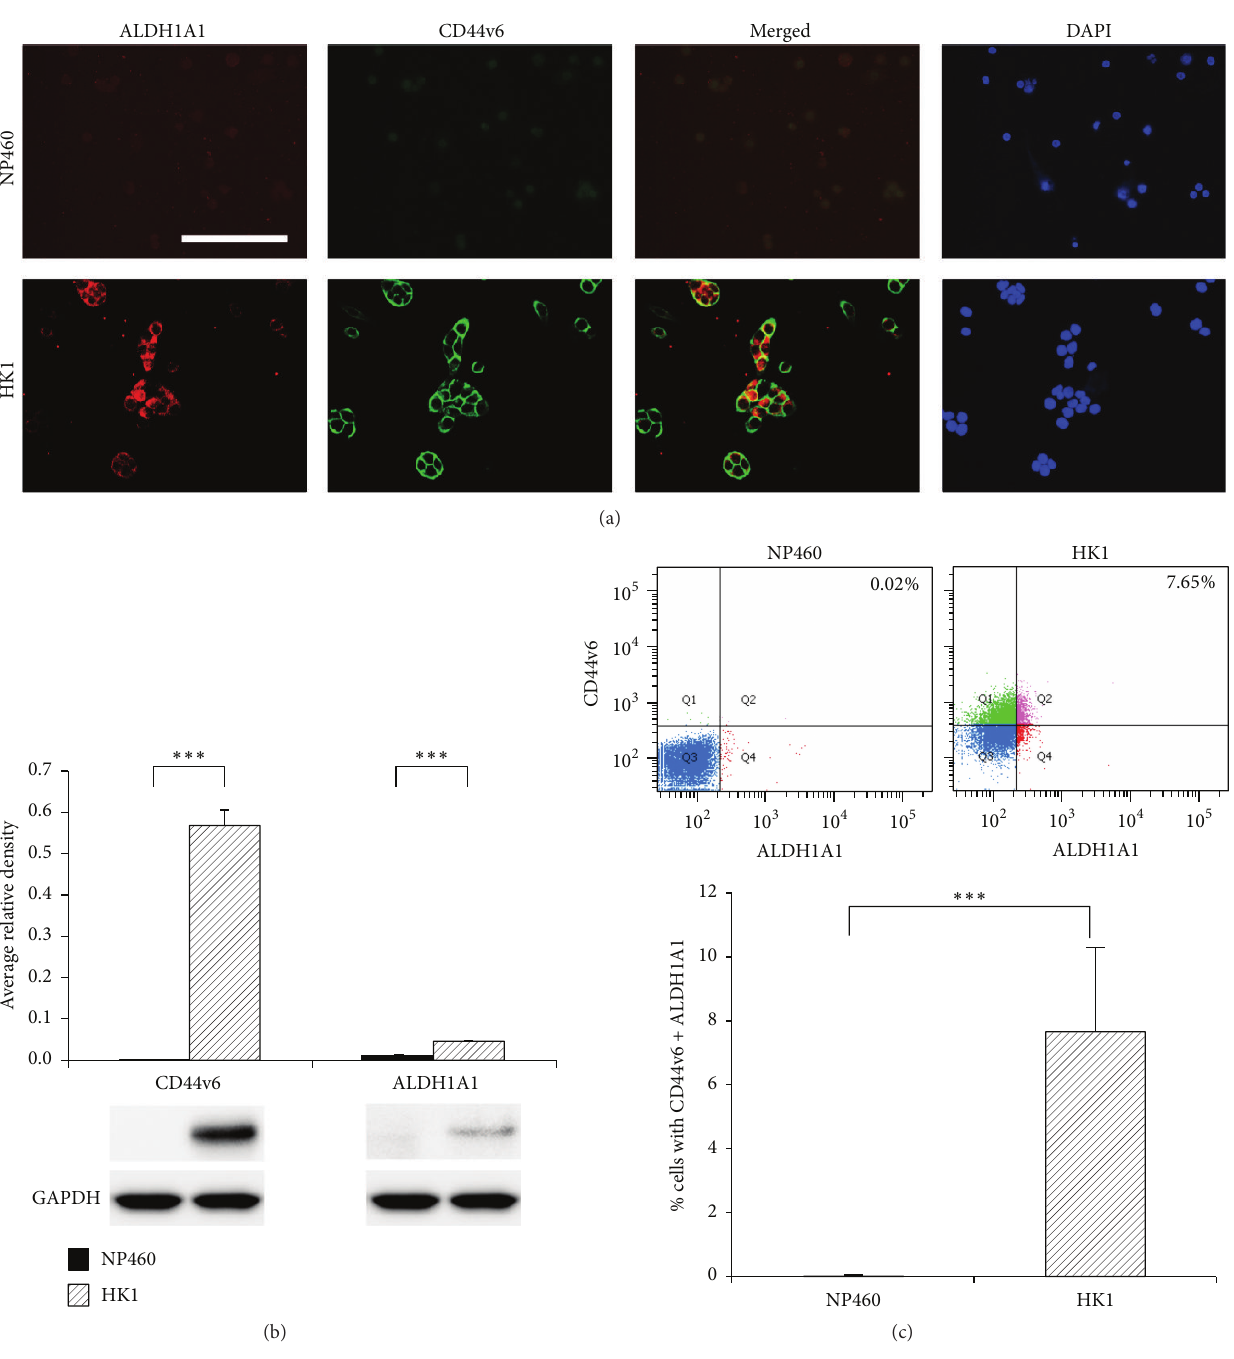
Figure 4: Expression of CD44v6 and ALDH1A1 in NP460 cells and HK1 cells. (a) Double immunofluorescence staining of CD44v6 (green) and ALDH1A1 (red) in a normal nasopharyngeal cell line NP460 and an NPC cell line HK1. Nuclei were counterstained by DAPI (blue). Original magnification is 400x. Scale bar represents 50 𝜇 m. (b) CD44v6 or ALDH1A1 levels in HK1 cells in comparison with NP460 cells by Western blot analysis ( 𝑛 = 4 ). Expression levels of target proteins (CD44v6 and ALDH1A1) were normalized against the corresponding levels of GAPDH. (c) HK1 and NP460 were stained with CD44v6 and ALDH1A1 and subjected to flow cytometry analysis ( 𝑛 = 6 ). Data are shown as mean ± standard deviation. 𝑃 values were calculated using Student’s 𝑡 -test ( ∗∗∗ 𝑃 < 0.001